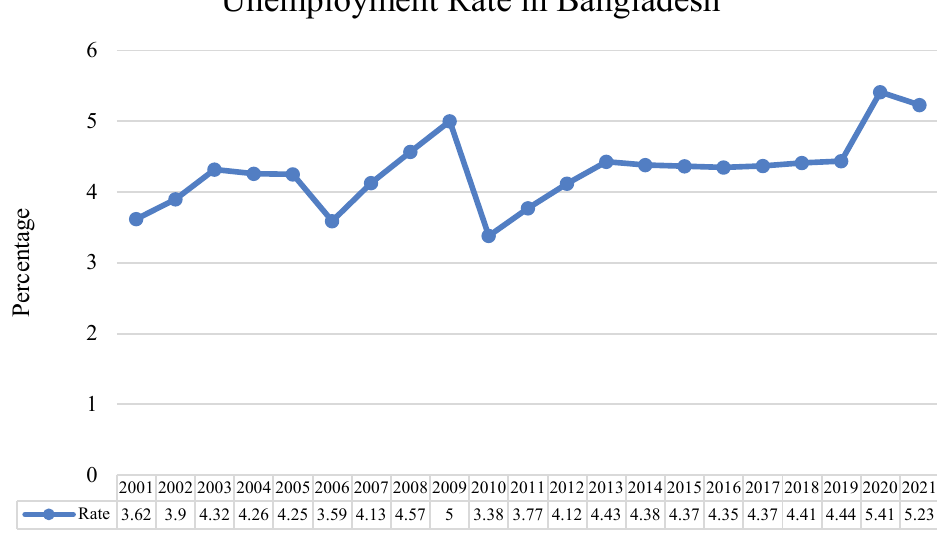
Fig. 1. The increasing unemployment rate in Bangladesh from 2001 to 2021 (The World Bank,